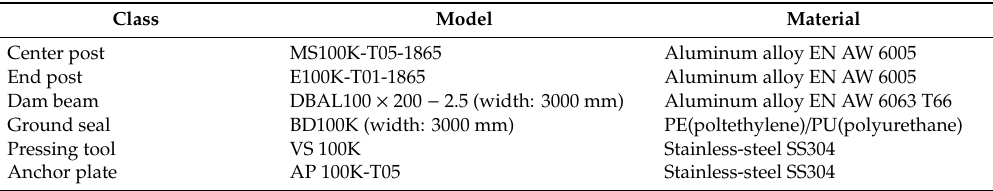
Table 1. Main structure parts and materials of removable floodwalls